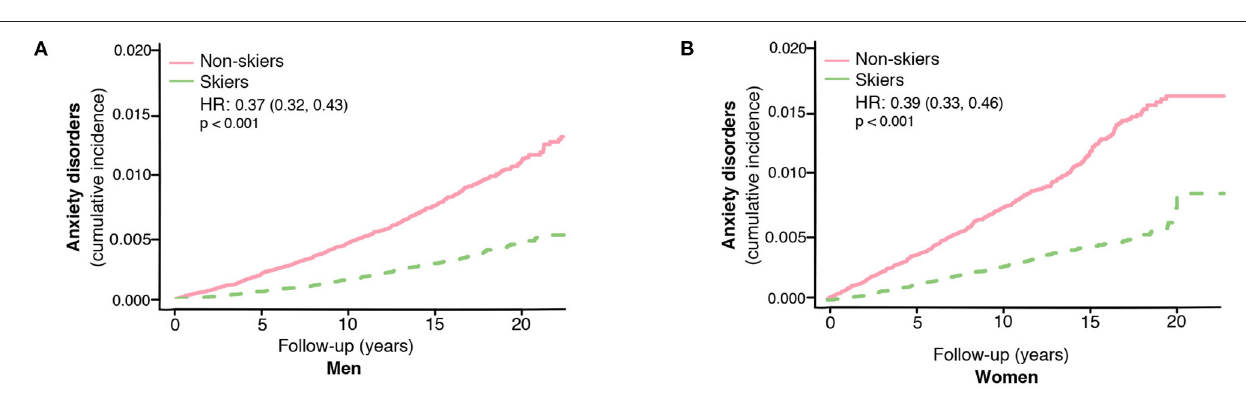
(unadjusted HR 0.37, 95% CI, 0.32–0.43 for men and